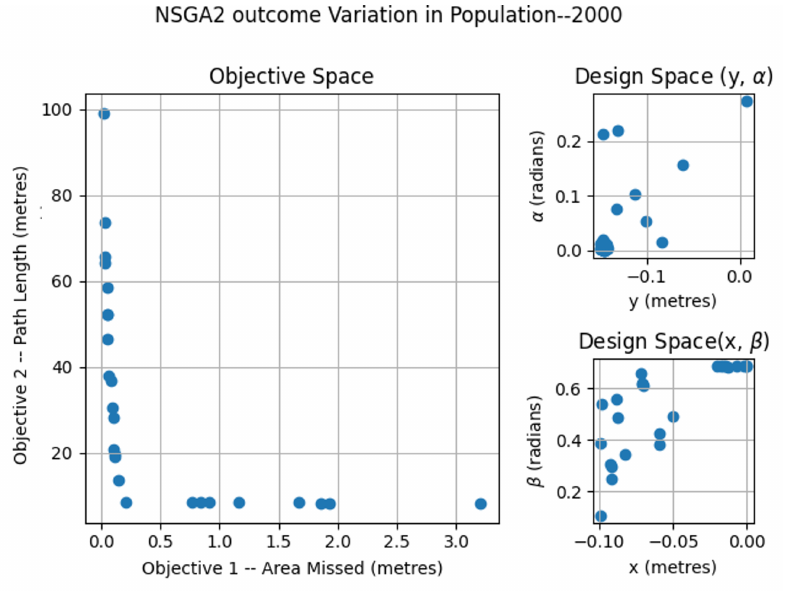
Figure 13. NSGA2 optimization for area size 3 × 2 m with population size =